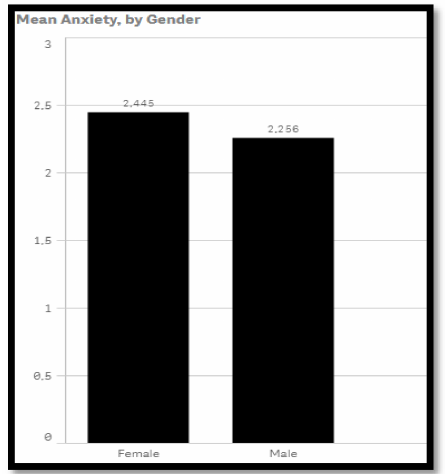
Figure 4. Anxiety, by Gender. Source: data study analysis.